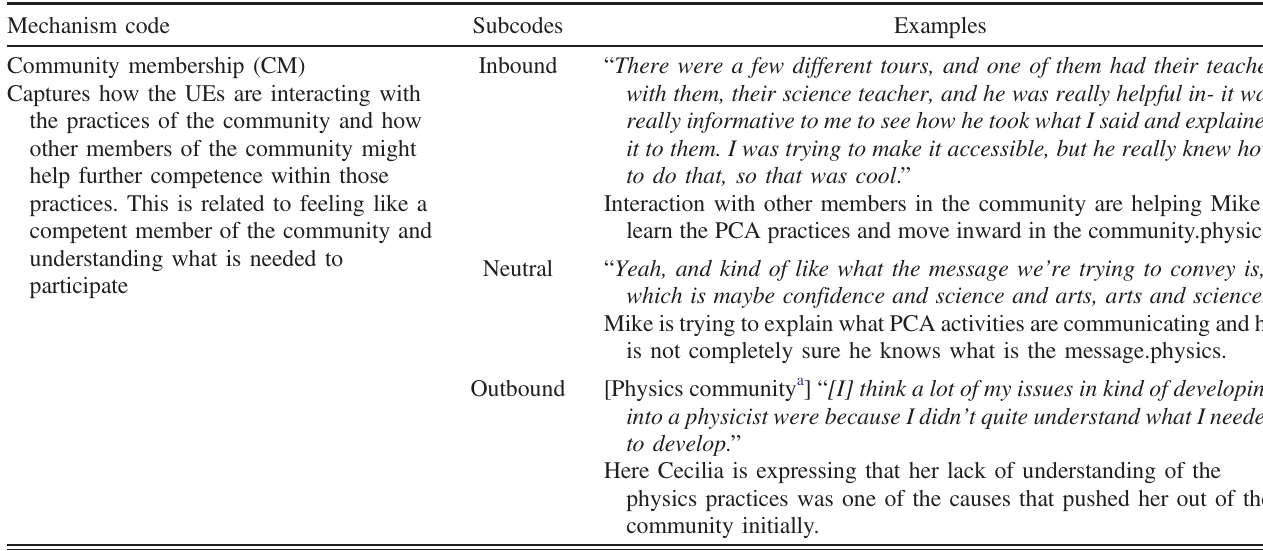
TABLE IX. Examples and explanations for each subcode under the community membership